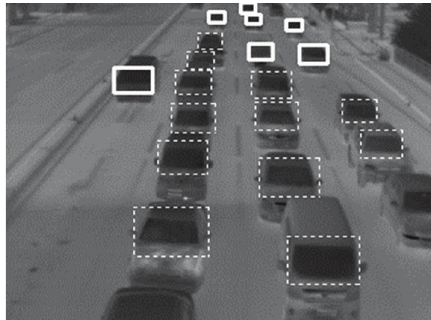
Figure 18: The image of frame number 30 in Figure